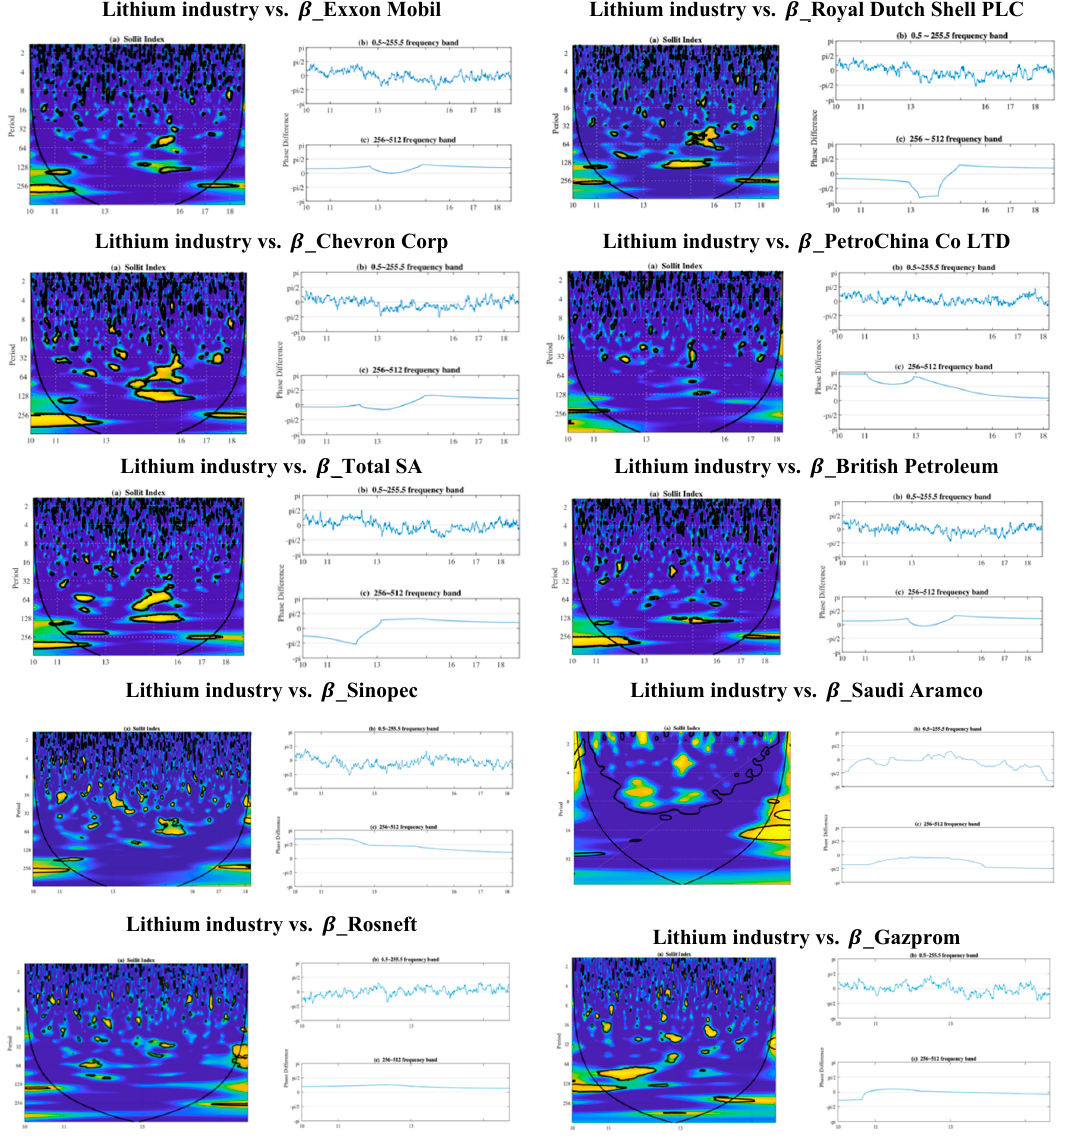
Figure 1. Wavelet coherency values and phase differences between each oil company and the Solactive Global Lithium Index. The contour represents the 5% significance level. The coherency ranges from blue (low coherency) to yellow (high coherency). Right: Phase difference at 0.5–255.5 days (top) and 256–512 days (bottom) frequency bands. The cone of influence is shown with a thick line, which is the region subject to border distortions.